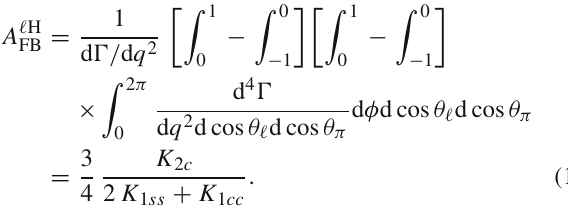
fractionoflongitudinallypolarizeddimuons F L (10)intheSM(orange) (14) (left FB and NP scenarios C 7 = 0 . 3, C (cid:3) = 0 . 5 and C (cid:3) = 0 . 3 in blue, or C (cid:3) green, respectively. Scenarios with C 9 and C 9 10 7 from the SM with F L and are not shown. The width of the bands stem predominantly from unknown strong